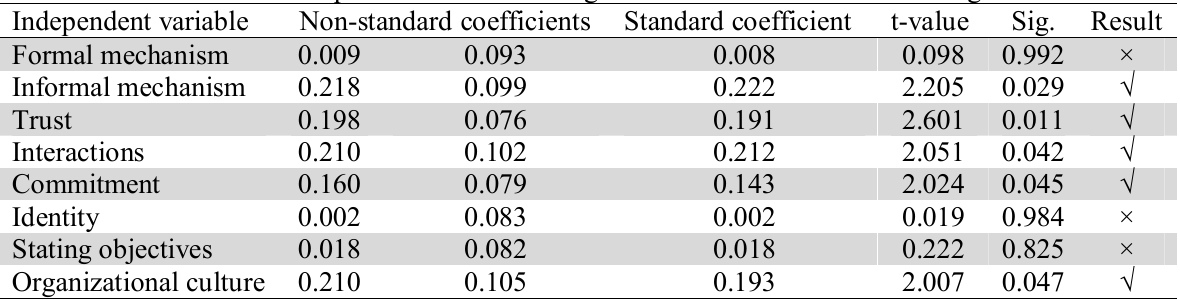
The results of the relationship between different organizational factors with knowledge distribution Independent